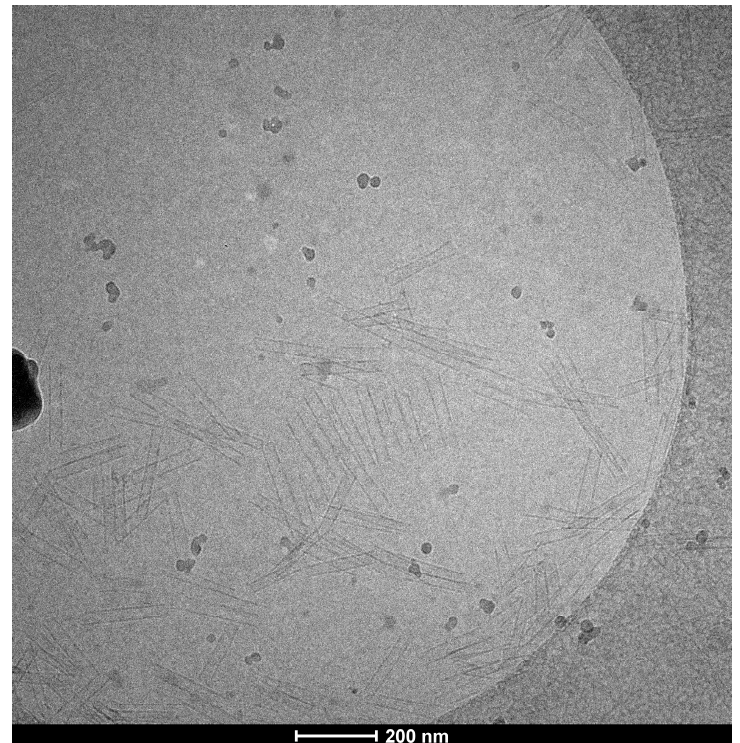
Figure 5. Cryo-TEM image of TPPS 3 ( 1 ) aggregates (the black drops correspond to the initial phase of the transformation of vitrified water to crystallized water).